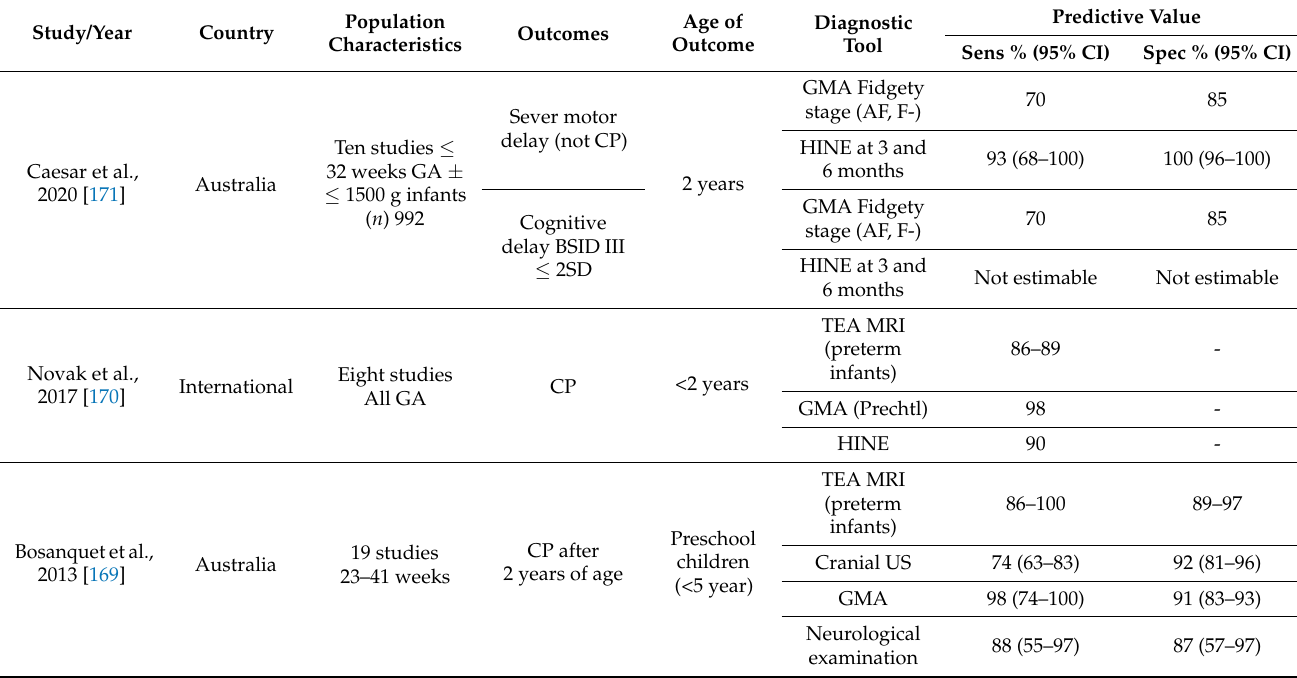
Table 5. The predictive value of tools used in the early (less than six months corrected age) identification of infants at risk of long-term neurodevelopmental